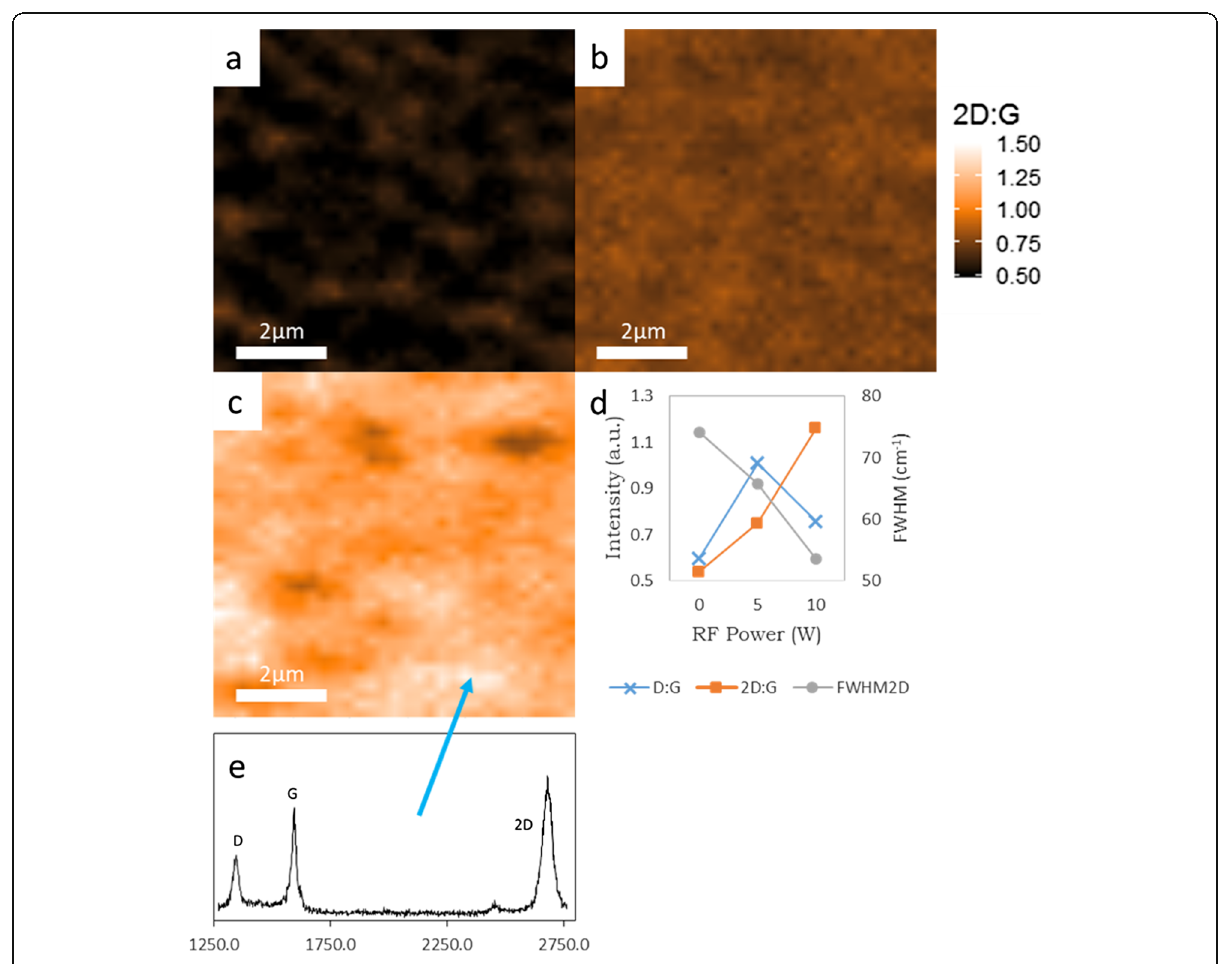
Fig. 4 Raman maps of graphene grown on 50 nm codeposited Ni-Au with 30s C 2 H 2 exposure time via a CVD, b ICPCVD with 5 W plasma, and c ICPCVD with 10 W plasma. The I 2D:G , I D:G , and FWHM 2D for each plasma power are shown in d where it is apparent that 10 W serves as the best due to its higher I 2D:G , lower I D:G , and smaller FWHM 2D compared to the others, and a representative spectra taken from the brightest region of c is shown in